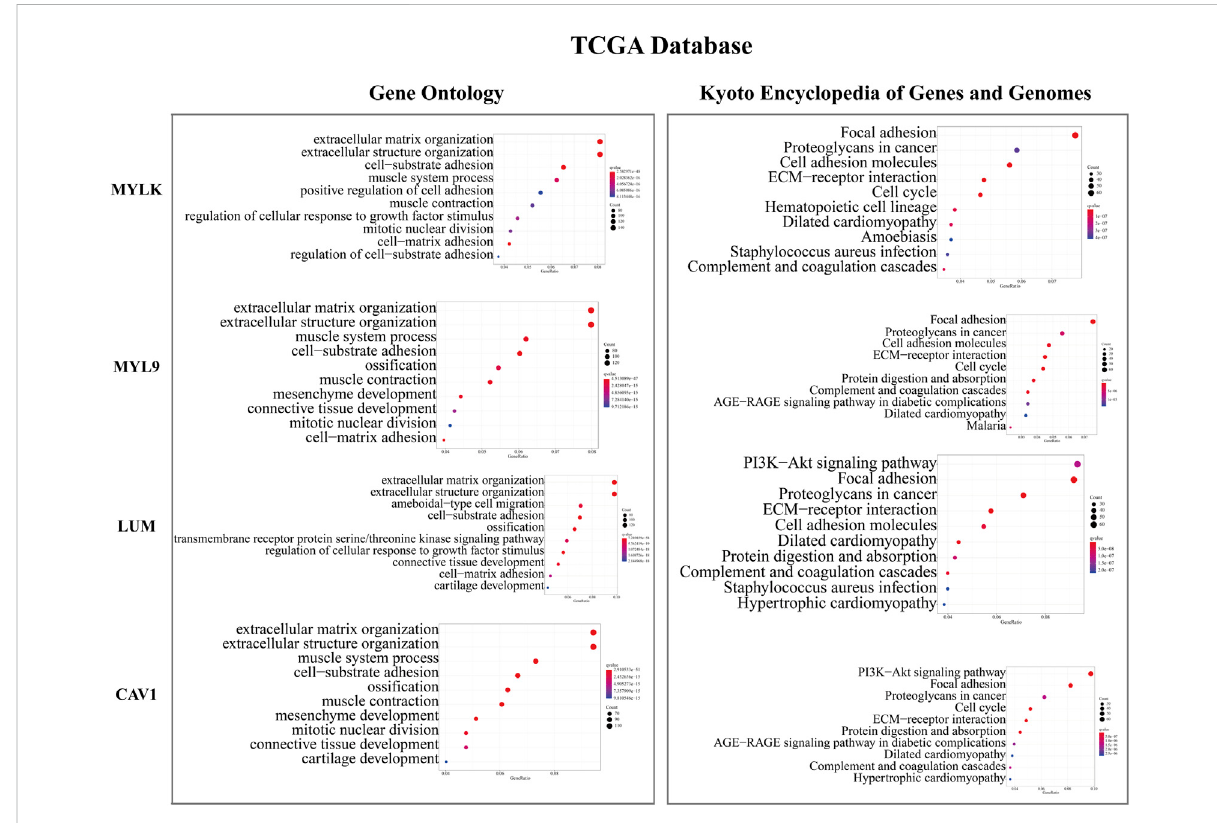
FIGURE 4 GO enrichment and KEGG enrichment analyses of key genes in TCGA